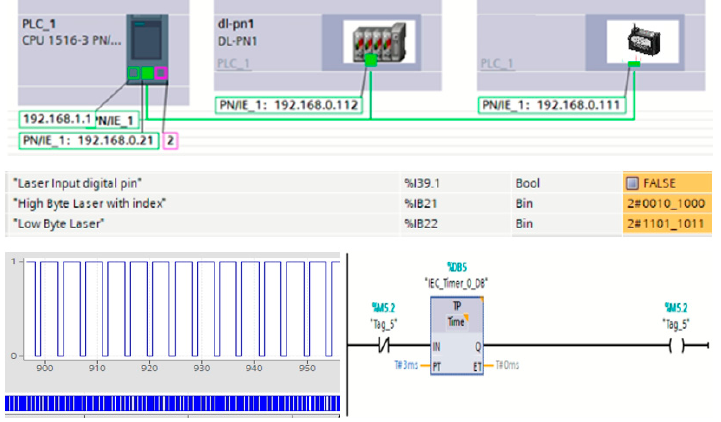
Figure 4. TIA portal configuration and graph for experimental setup for stable pulses generation.